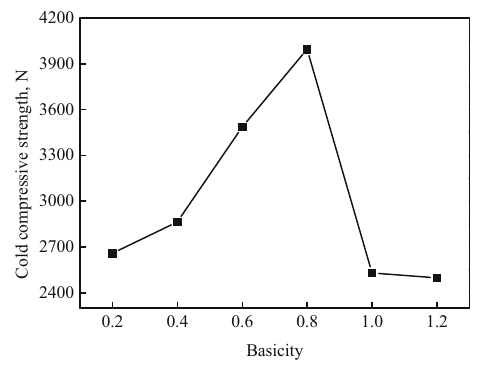
Figure 3: Cold compressive strength variation of the iron ore bri - quettes with di ff erent basicity values.